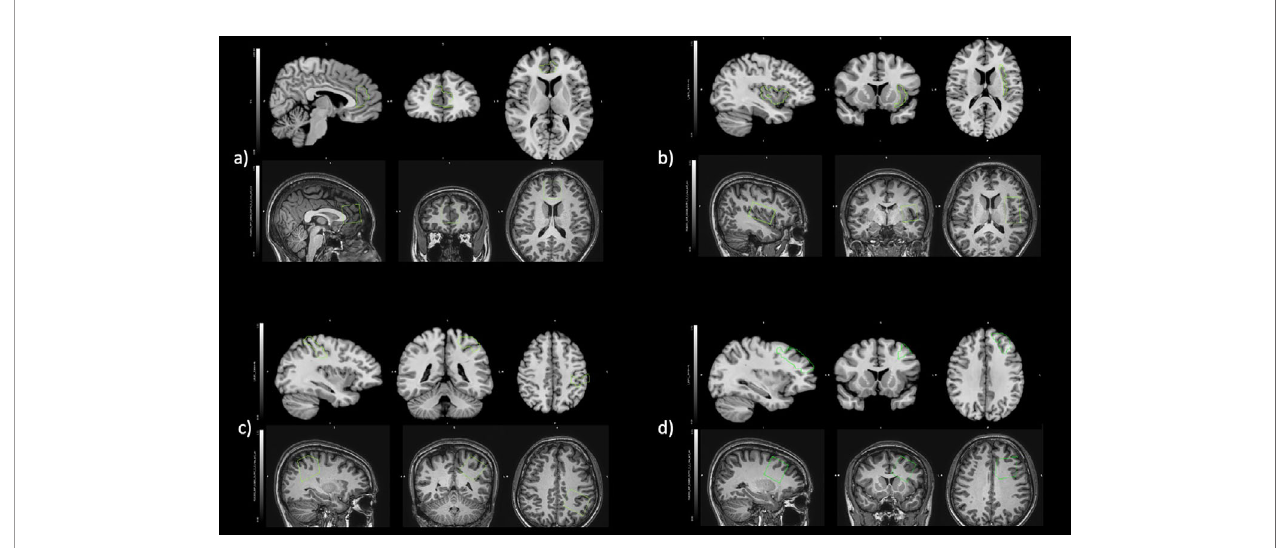
FIGURE 1 | Positioning of regions of interest in fALFF (Top) and MRS (Bottom) for (A) bilateral pregenual anterior cingulate cortex, (B) left insula, (C) left somatosensory cortex, and (D) left dorsolateral prefrontal